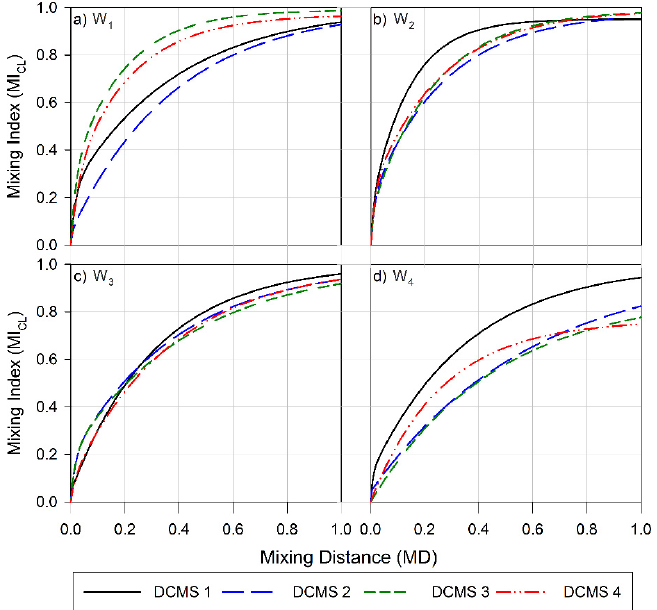
Figure 3. Mixing index for the channel layers (CL) versus the channel length for ( a ) Wafer 1, ( b ) Wafer 2, ( c ) Wafer 3, and ( d ) Wafer 4. Data obtained for channels with parameter design variables (PDV, Table 1) are depicted as follow: PDV 1 is a black solid line, PDV 2 is a blue long-dashed line, PDV 3 green is three short-dashed lines and PDV 4 is a red dashed-dot-dot line.